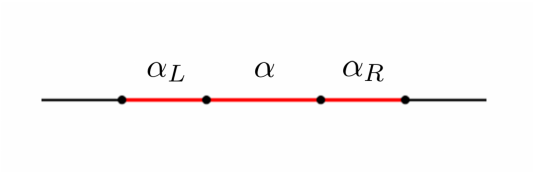
Figure 1: A typical region A with a definite order is shown by the red